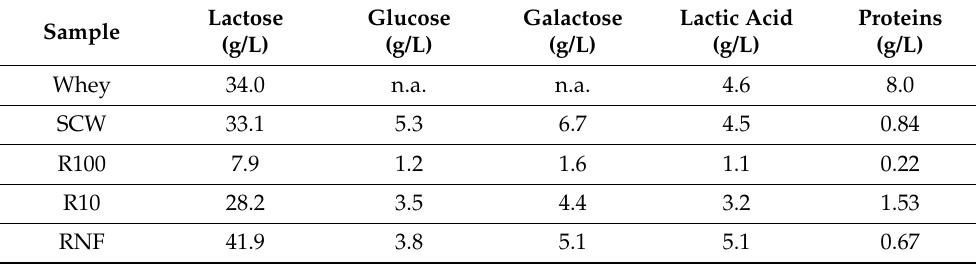
Table 2. Concentration of carbon sources (lactose, glucose, and galactose), lactic acid, and proteins found in the initial whey sample, in SCW, and in ultrafiltration and nanofiltration retentates. n.a. not